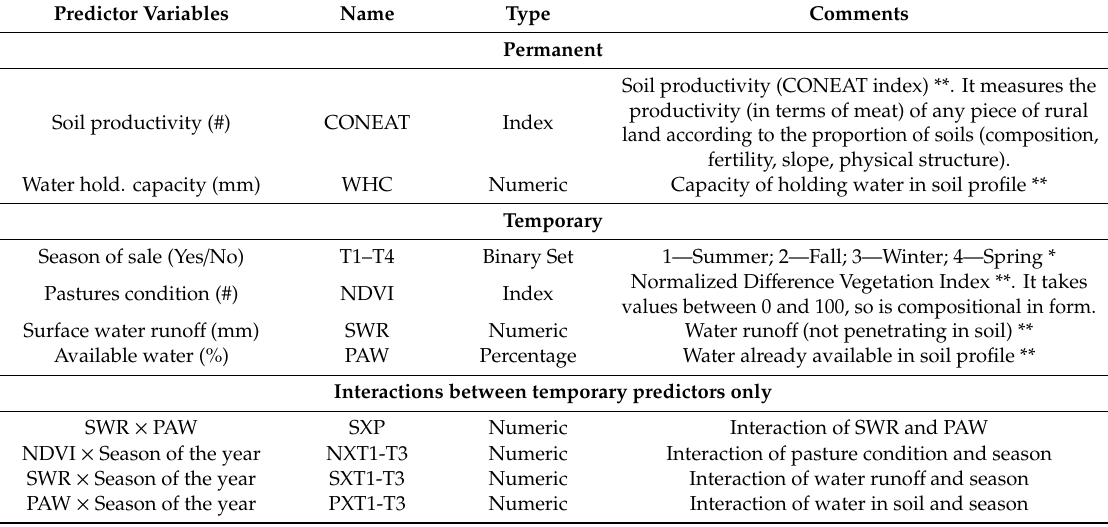
Table 2. Agro-ecological conditions used as predictor